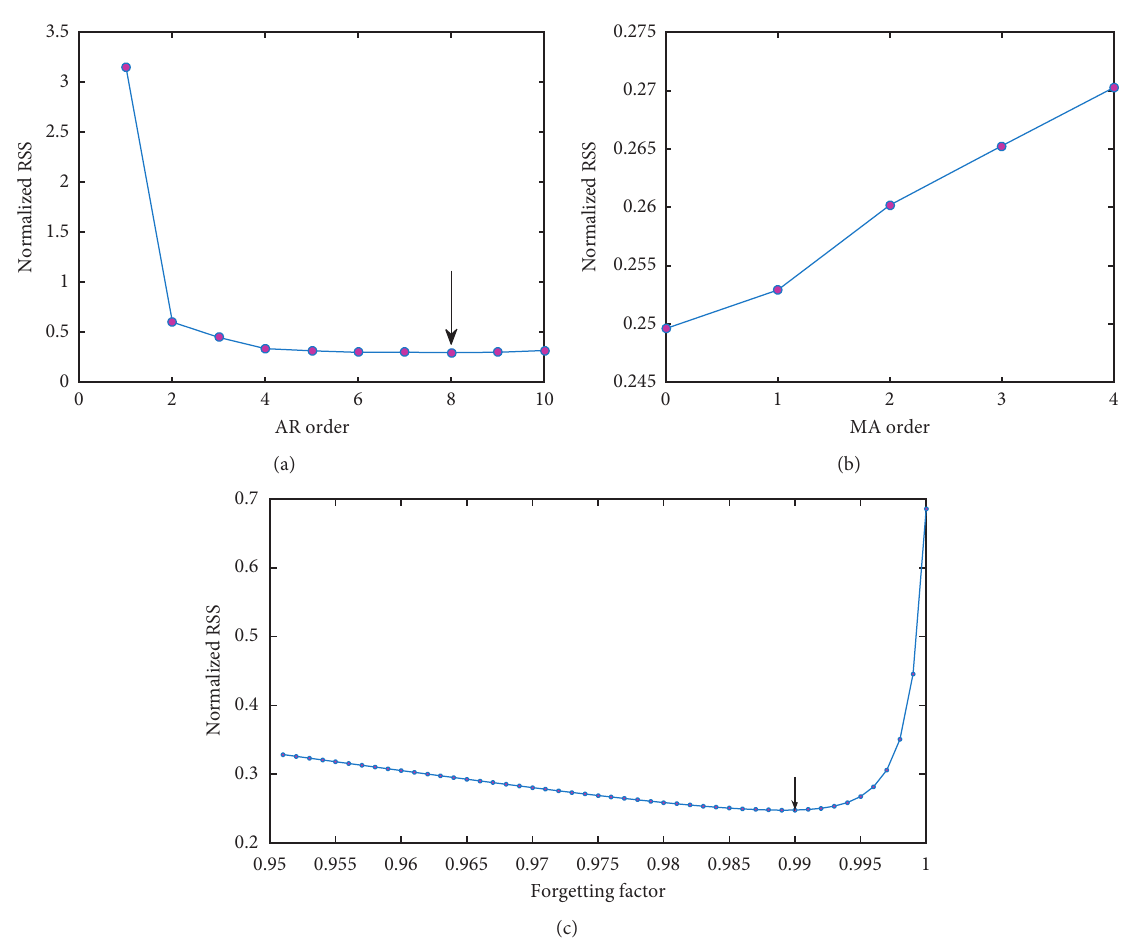
Figure 5: EWRPLR-TARMA model order selection: (a) AR order, (b) MA order, and (c) forgetting factor.